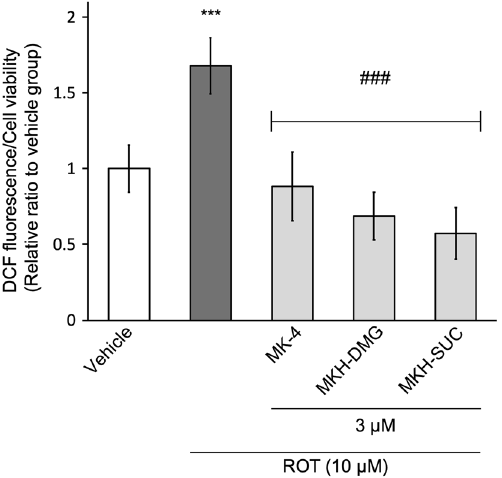
Figure 5. Influence of MK-4 and MKH derivatives on ROT-induced ROS. The NIH/3T3 cells were treated with 3 µM MK-4, MKH-DMG, or MKH-SUC for 6 h in the presence of 10 µM ROT. Intracellular ROS levels were determined by DCFH-DA staining. The relative luminescence unit (RLU) obtained using the DCFH-DA reagent was standardized by RLU from the CTB assay as the living cell number. ***p < 0.001 versus vehicle group; ### p < 0.001 versus ROT only group (Tukey’s test). Mean ± SD (n = 3).